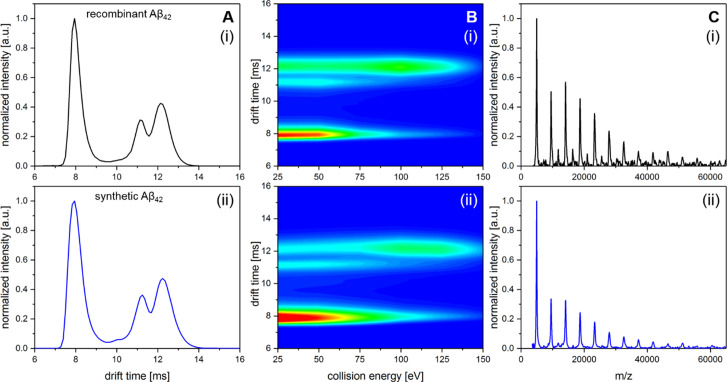
Comparison of recombinant Aβ42 and Aβ42 synthesized via Fmoc chemistry.A shows IM spectra of the D5+ signal for recombinant (i) and synthetic (ii) peptide. In both cases all signals in the respective IM spectra appear at the identical drift times. B shows heat maps of the CIU experiment for recombinant (i) and synthetic (ii) peptide. Only a slight difference in signal intensity between the compact and the unfolded MB dimer can be observed. However, the ratio where 50% of dimeric Aβ42 is unfolded appears in both cases to be at about 85 eV. C shows LILBID spectra for recombinant (i) and synthetic (ii) peptide incubated at 22°C for 200 min. Intensity differences of the oligomers between (i) and (ii) are on the level of reproducibility of the experiments.